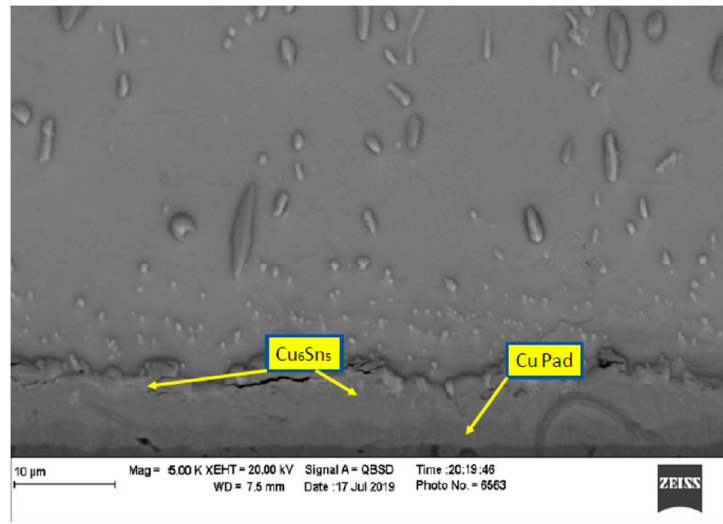
Figure 7. Microstructure of SAC305 fused to a copper pad then thermally aged at 150 ◦ C for 100 h.